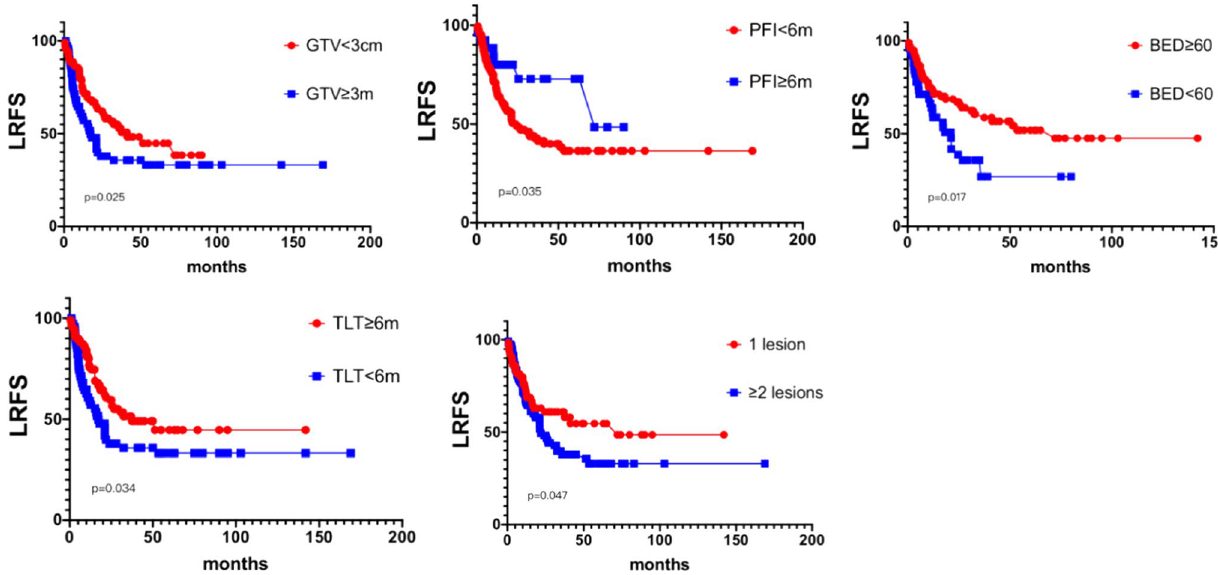
Fig. 3 LRFS and subgroup analysis. LRFS: Local Recurrence Free Survial, GTV, PFI, TLT,BED Fig. 4 Kaplan–Meier curve for progression free survival (PFS) of the 189 treated lesions over time (solid line). The dashed lines indicate 95% confidence intervals